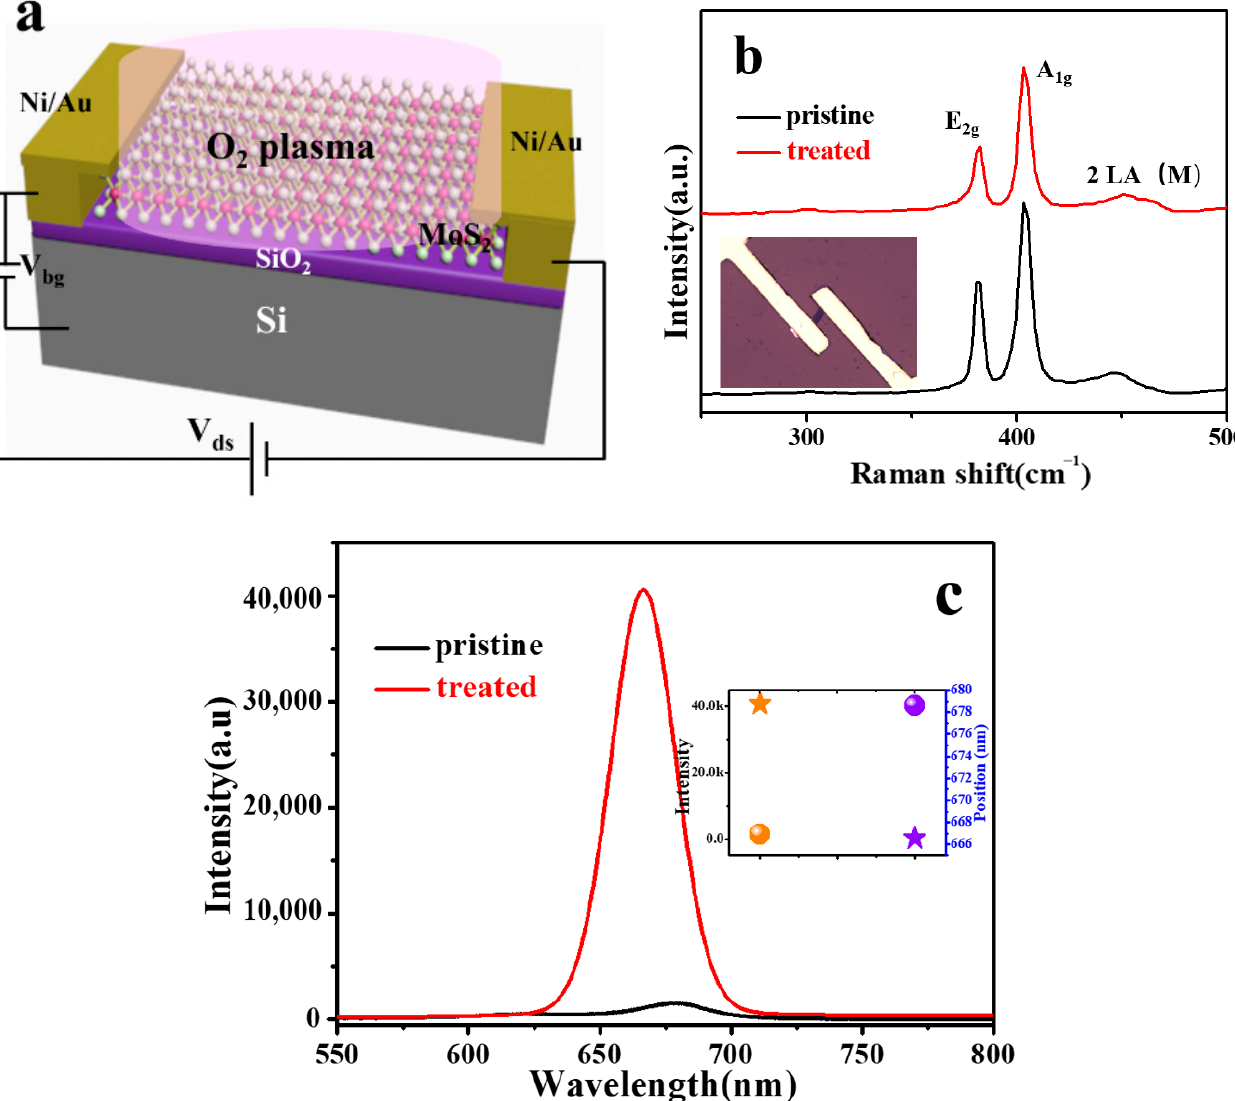
Figure 1. Evolution of optical properties of MoS 2 after mild oxygen plasma irradiation. ( a ) Schematic of the process of mild plasma treatment of MoS 2 device. ( b ) Raman and ( c ) PL spectra of few layer MoS 2 before and after oxygen plasma treatment. Inset of ( b ) is the image of the MoS 2 device and inset of ( c ) is the intensity and position of PL peaks.